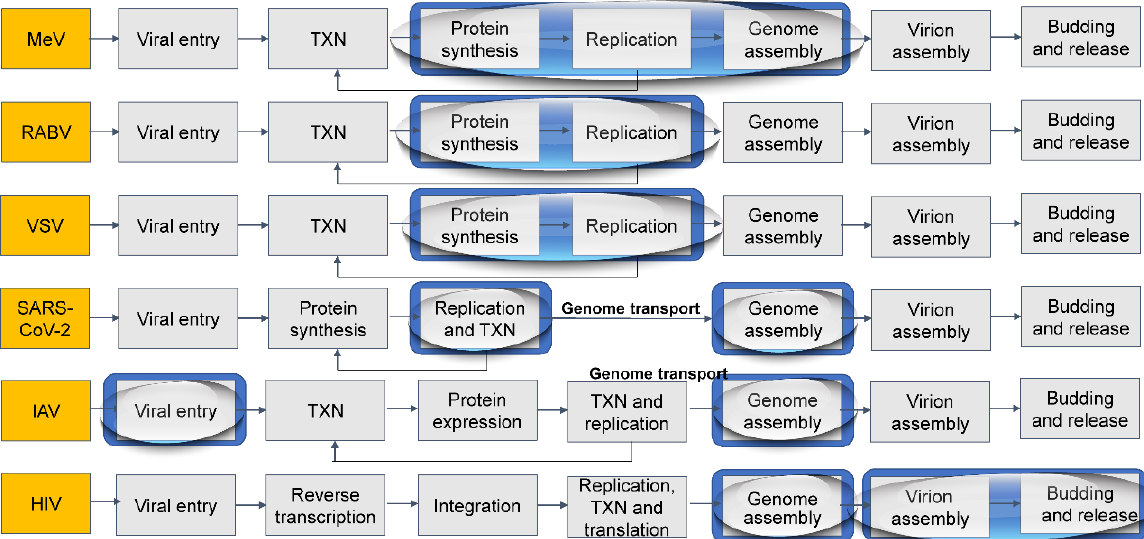
Figure 8. Graphical summary of the steps of the lifecycle of selected viruses, highlighted in the yellow box, with the inclusion, in blue, of the steps taking place in liquid organelles. Abbreviations mean transcription (TXN), measles virus (MeV), rabies virus (RABV), vesicular stomatitis virus (VSV), severe acute respiratory syndrome coronavirus-2 (SARS-CoV-2), influenza A virus (IAV), and human immunodeficiency virus (HIV). The graphical representation is inspired by adverse output pathways models.